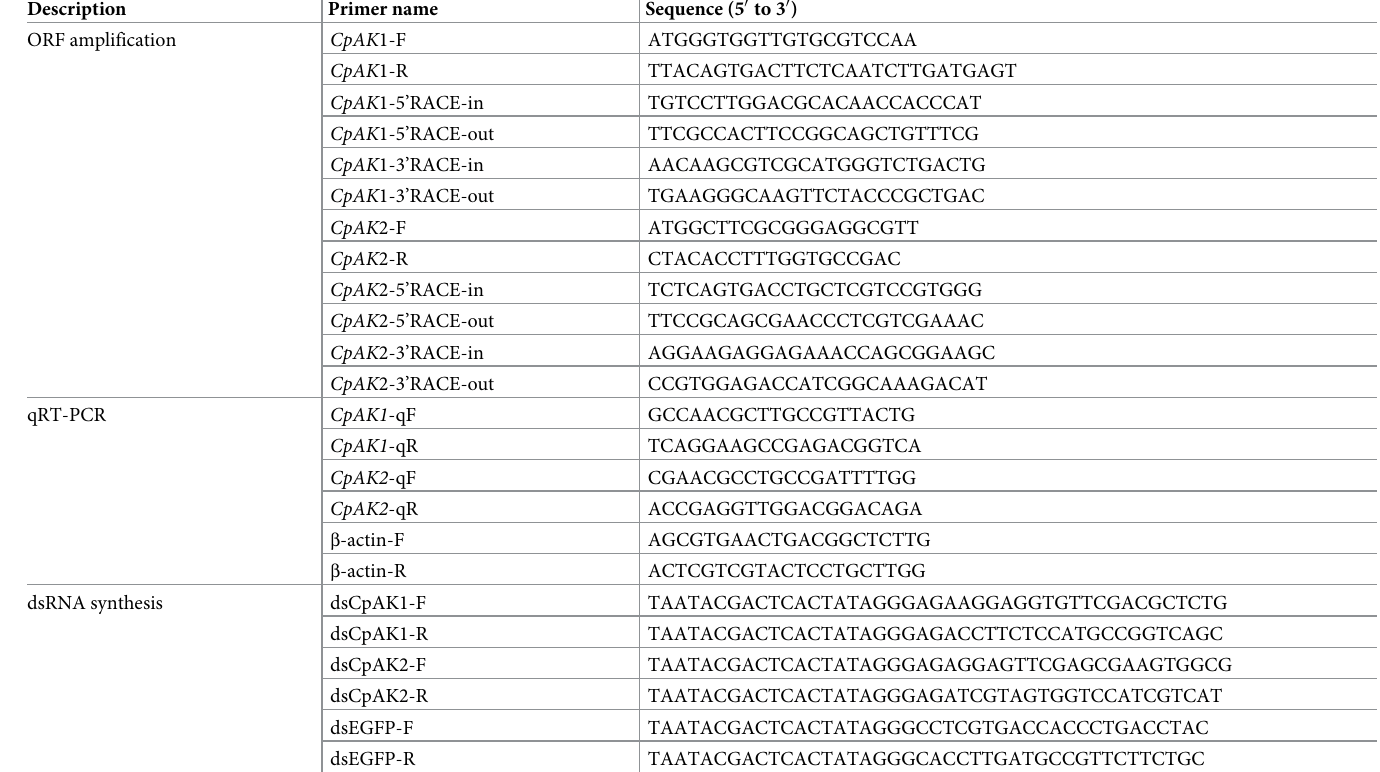
Table 1. The primers used in this